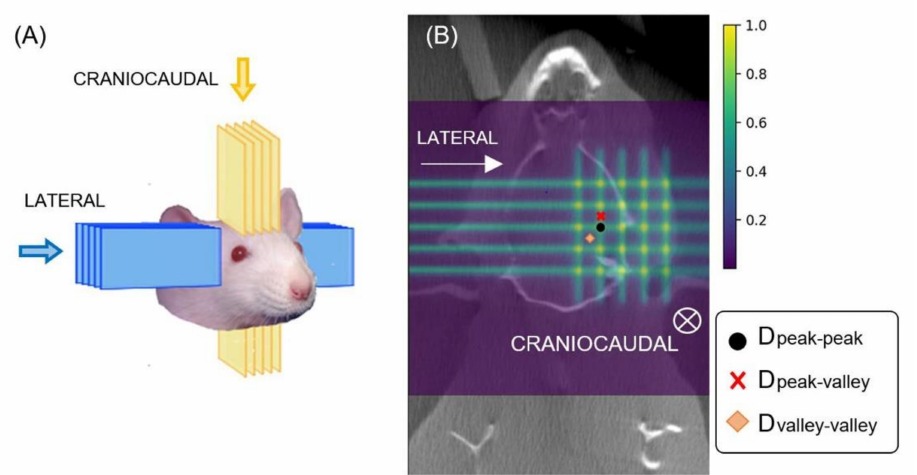
Figure 1. ( A ): pMBRT crossfire irradiation geometry. In blue, the lateral path of the beams. In yellow, the craniocaudal irradiation. ( B ) Coronal 2D dose maps in the crossfire pMBRT